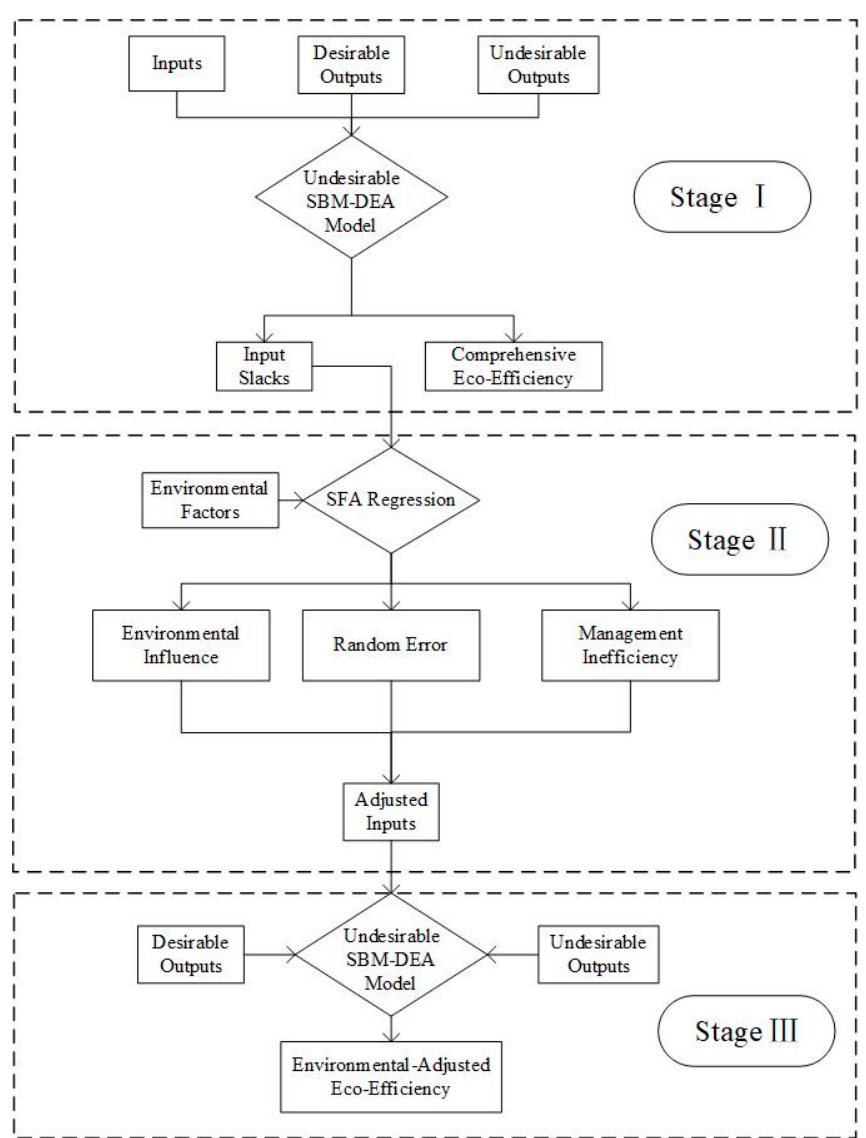
Figure 1. Methodological framework of the evaluation of eco-efficiency of the tourism industry.